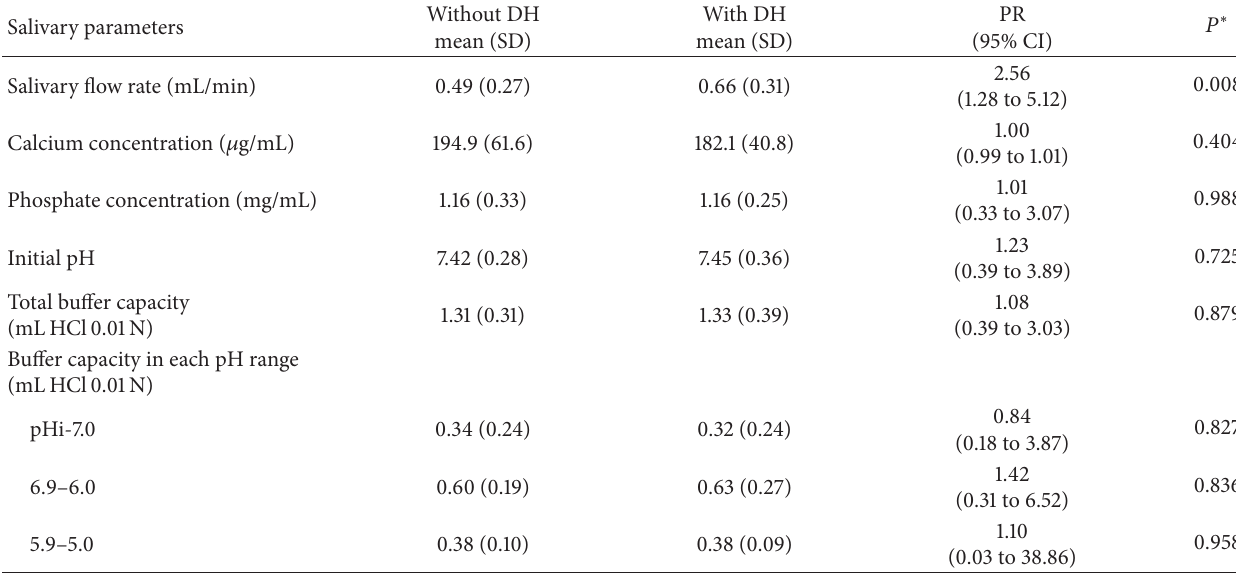
Table 3: Univariate Poisson regression analysis between salivary parameters and presence of dental hypersensitivity. Salivary